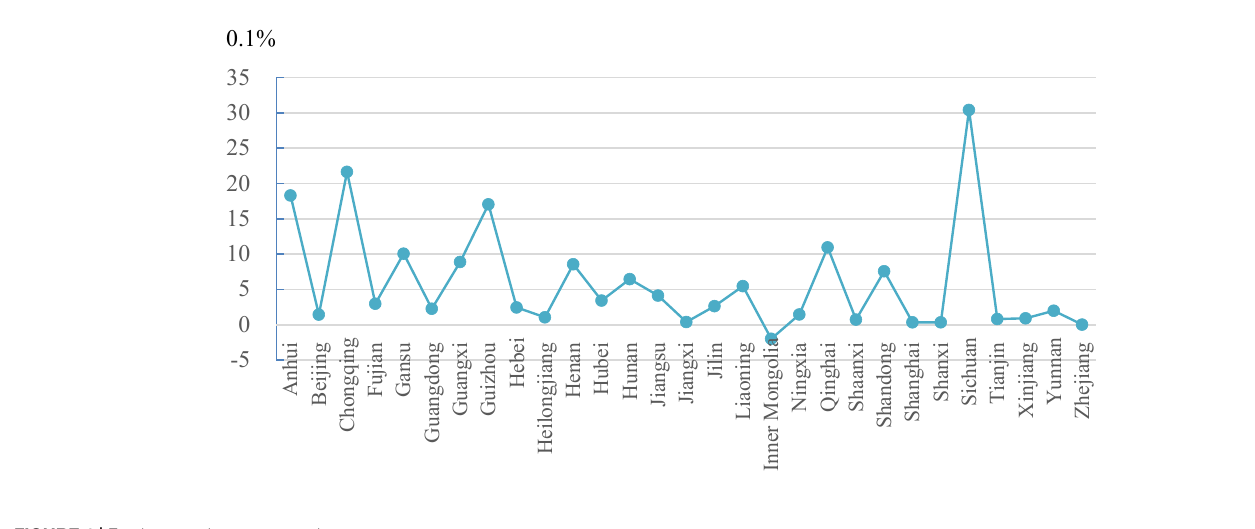
FIGURE 1 | Famine severity across provinces.